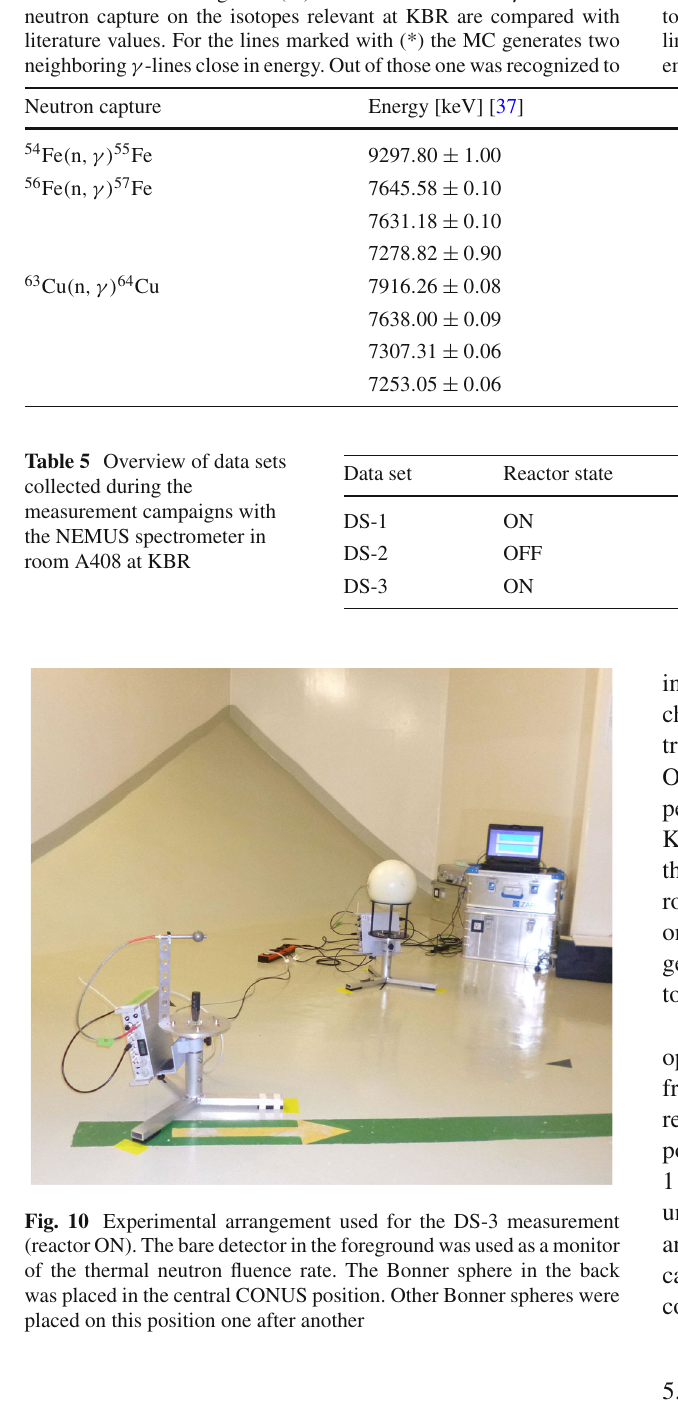
be not physical and was neglected. The absolute branching ratio refers to the ratio of emitted γ -rays per neutron capture (given for strongest